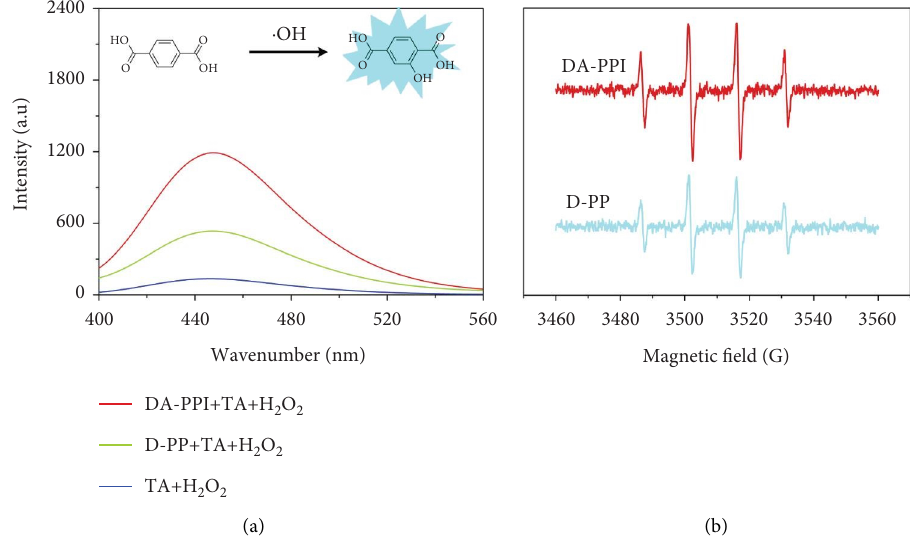
Figure 5: Te fuorescence spectra of diferent samples (a). Te ESR spectra of diferent samples with H and DA-PPI nanozyme